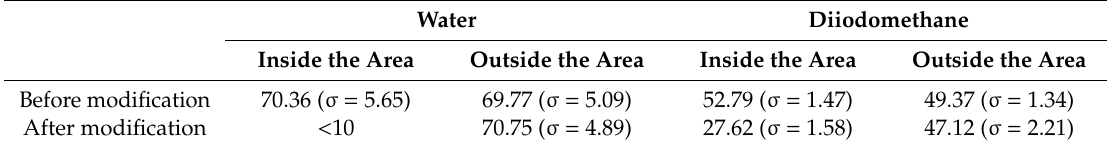
Figure 5. The sample contact angles measured outside ( a , b ) and inside ( c , d ) of the discharge area before ( a , c ) and after ( b , d ) the modification, using water droplets. A change in the appearance is visible only in the case of the measurement after the modification, inside the discharge area. Table 2. Contact-angle measurement mean results.